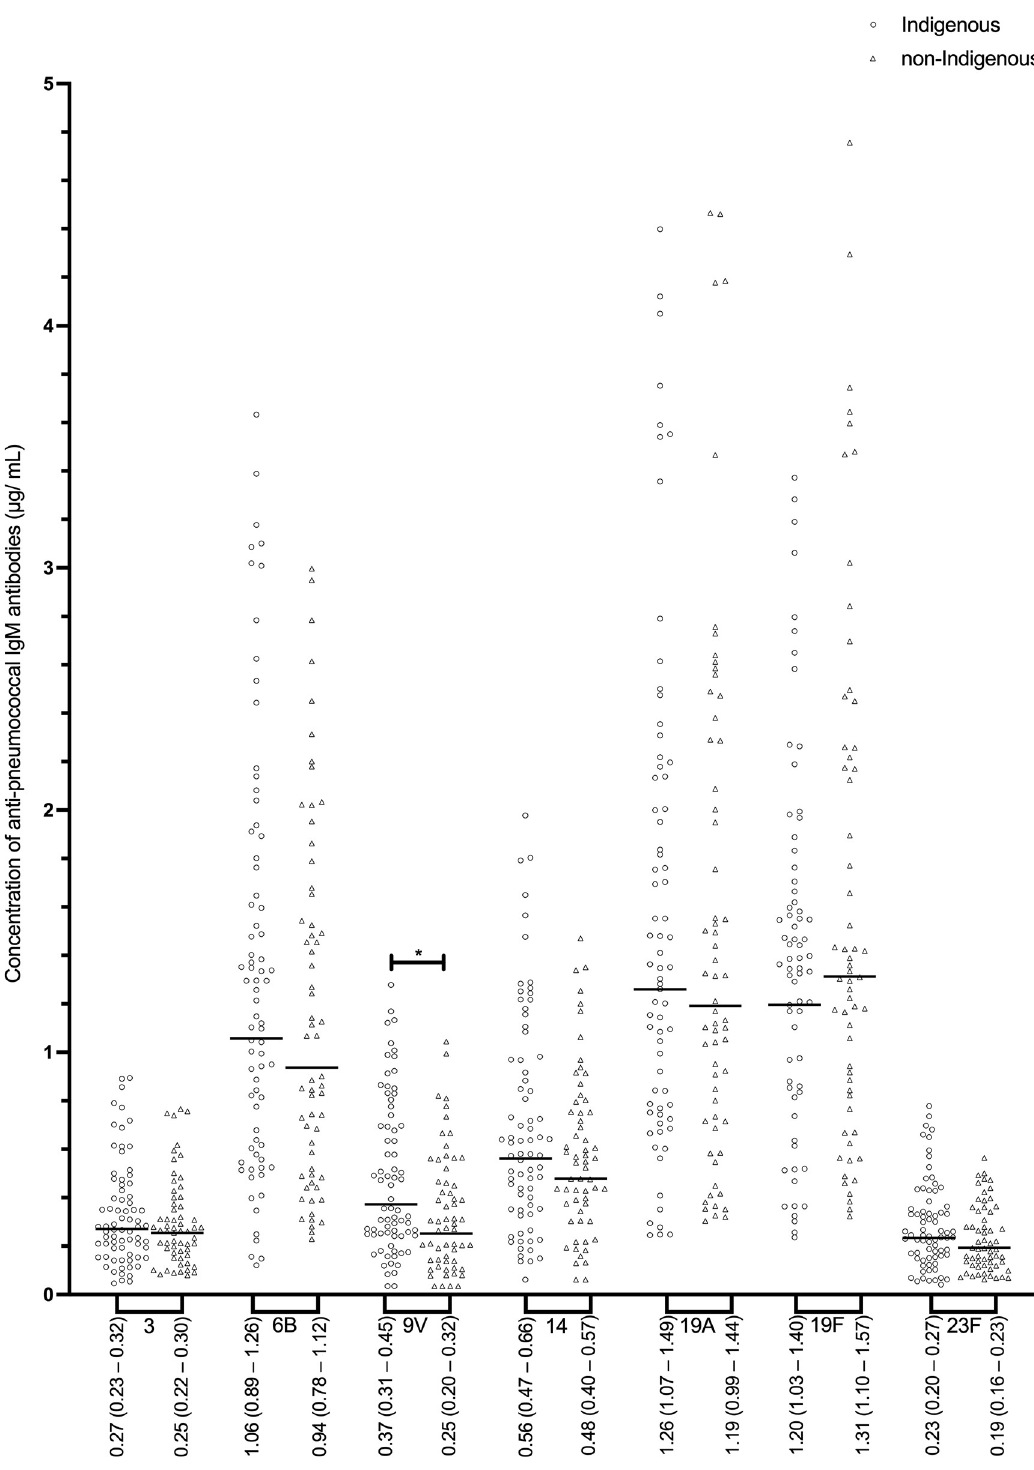
Fig 2. Concentrations of serotype-specific pneumococcal IgM antibodies for Indigenous (n = 77) and non-Indigenous groups (n = 64). Geometric mean antibody concentrations (GMC) are displayed ( μ g/ mL) and the 95% confidence intervals of the GMC. Statistical significance was determined using a Mann-Whitney U test for all serotypes. � p < 0.05.